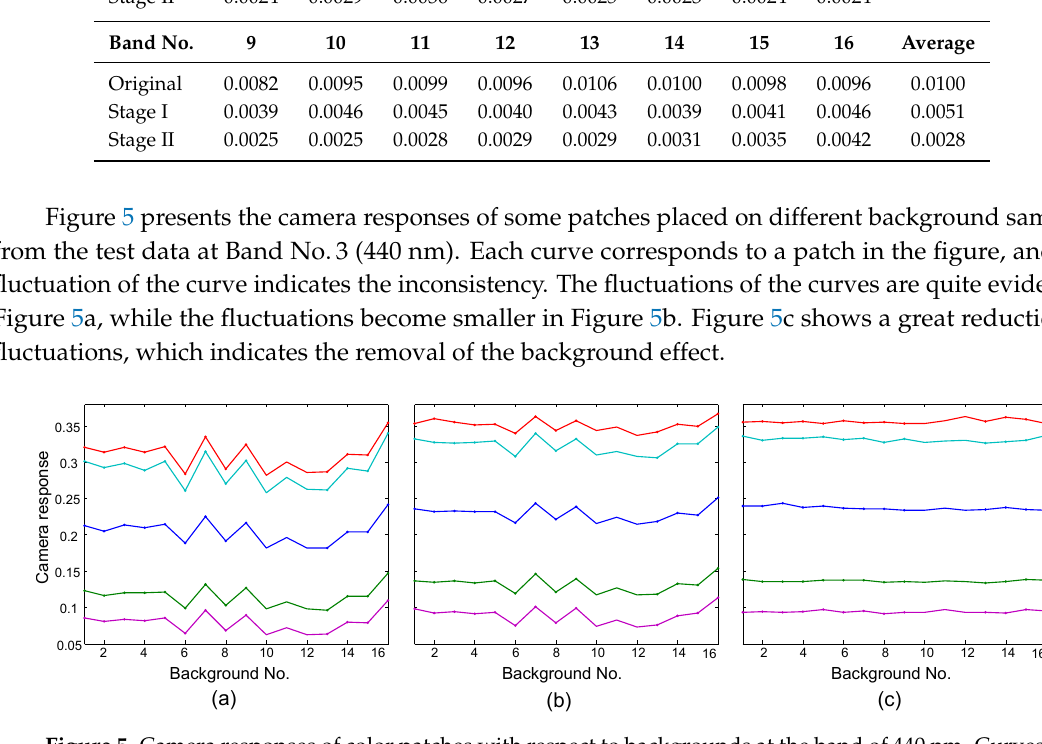
Figure 5. Camera responses of color patches with respect to backgrounds at the band of 440 nm. Curves in different colors correspond to different patches. ( a ) Original, ( b ) Stage I, and ( c ) Stage